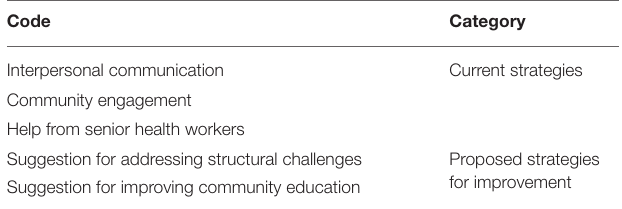
TABLE 2.4 | Codes and categories for Theme 4: “CHWs use context-specific strategies to address challenges in their work but require further support”, qualitative assessment, Western Area Urban, Sierra Leone,